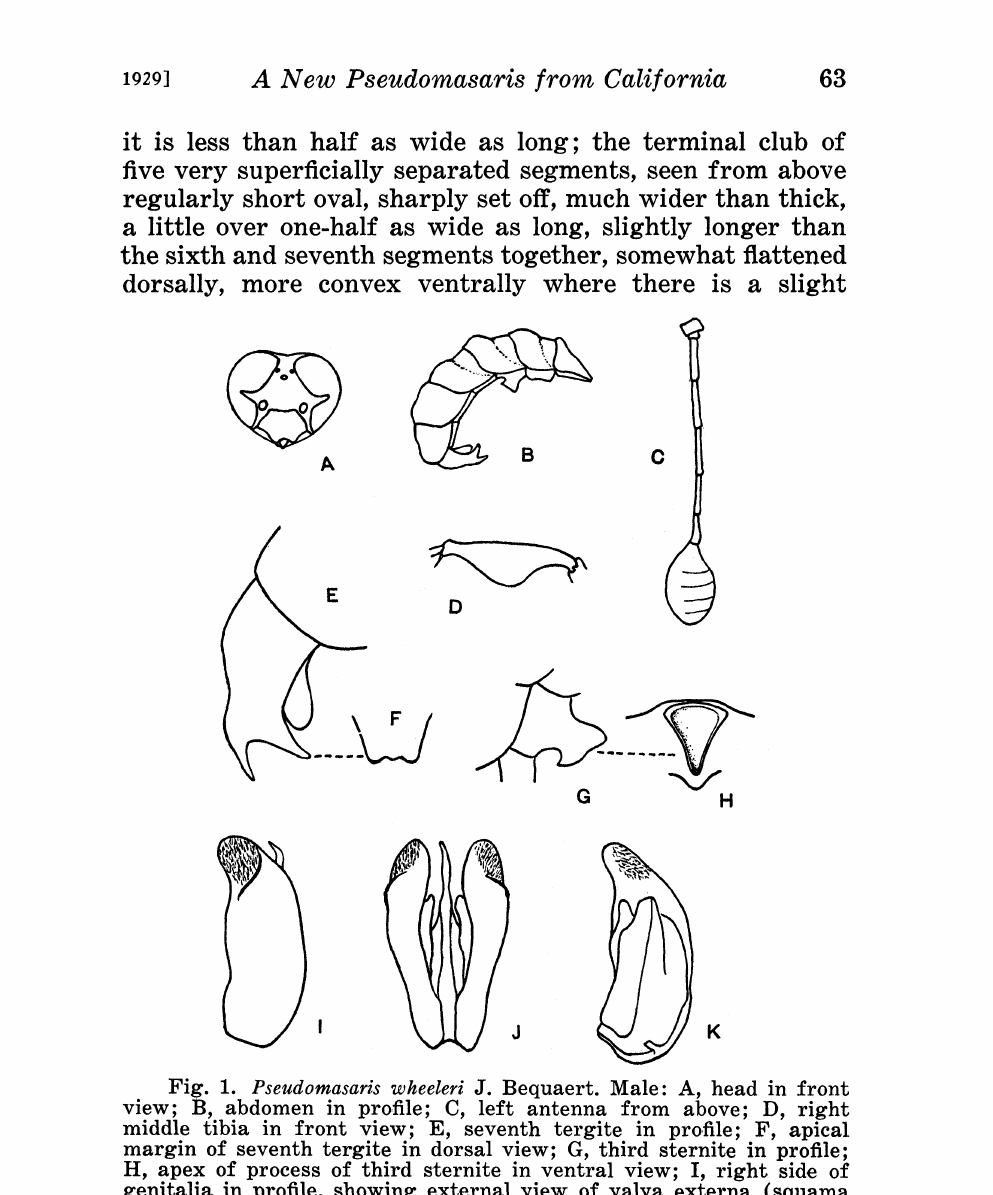
Fig. 1. Pseudomasaris wheeleri J. Bequaert. Male: A, head in front view; B, abdomen in pro.file; C, left antenna from above; D, right middle tibia in front view; E, seventh tergite in profile; F, apical margin of seventh tergite in dorsal view; G, third sternite in profile; H, apex of process of third sternite in ventral view; I, right side of genitalia in profile, showing external view of valva externa (squama of Bradley); J, genitalia in dorsal view; K, internal view of left valva externa (Bradley’s squama), howing valva interna (Bradley’s sagitta and